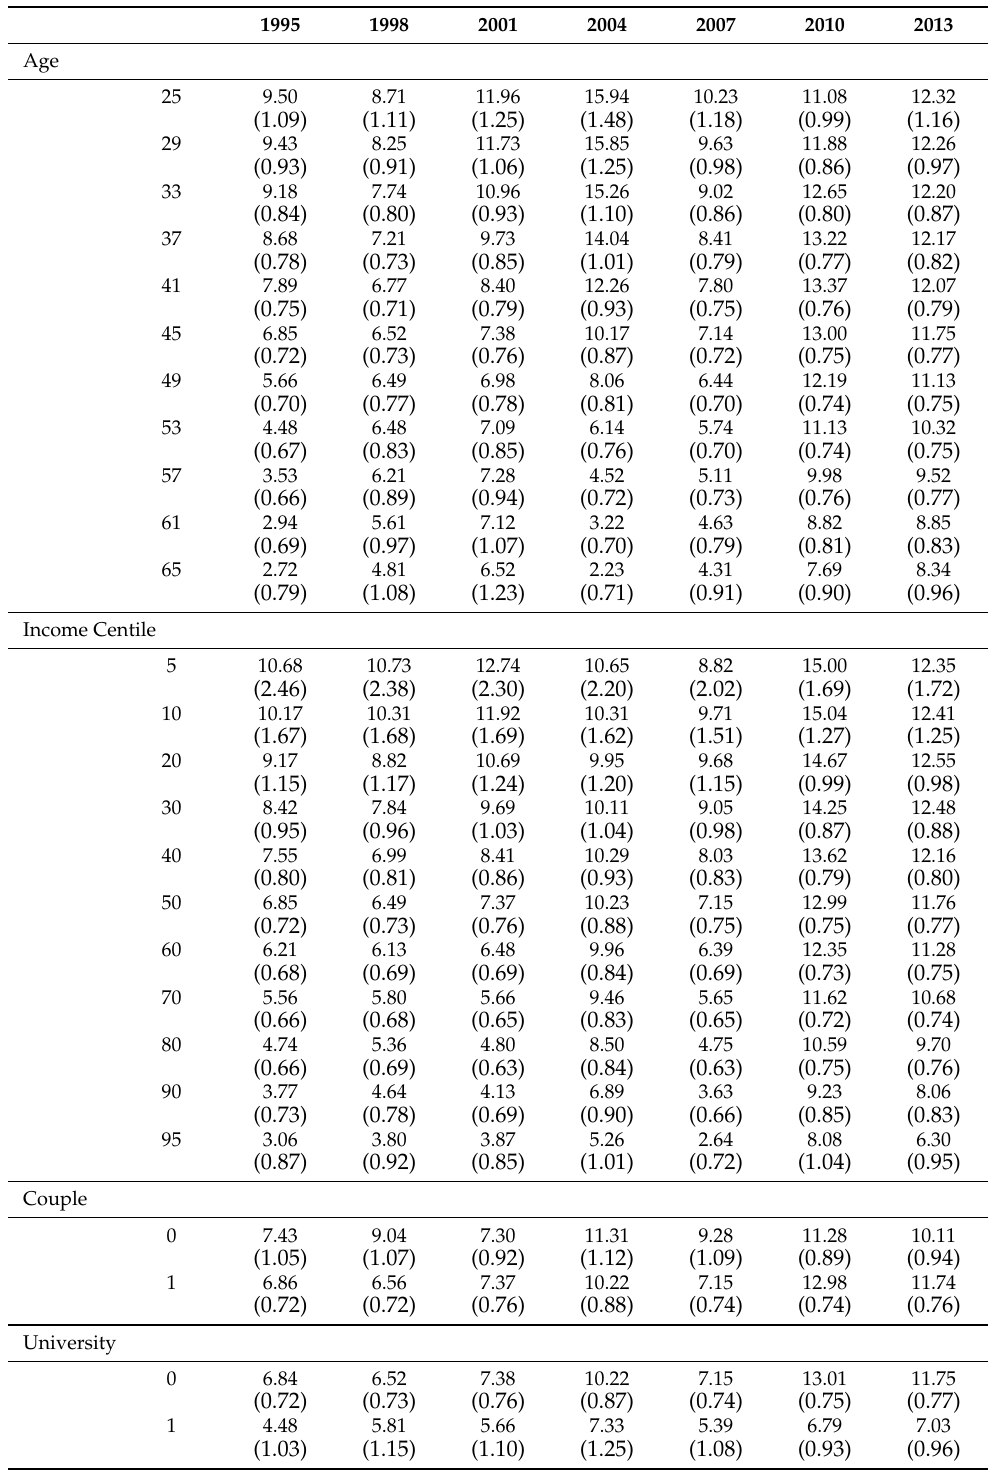
Table A4. Estimates of Arrears for